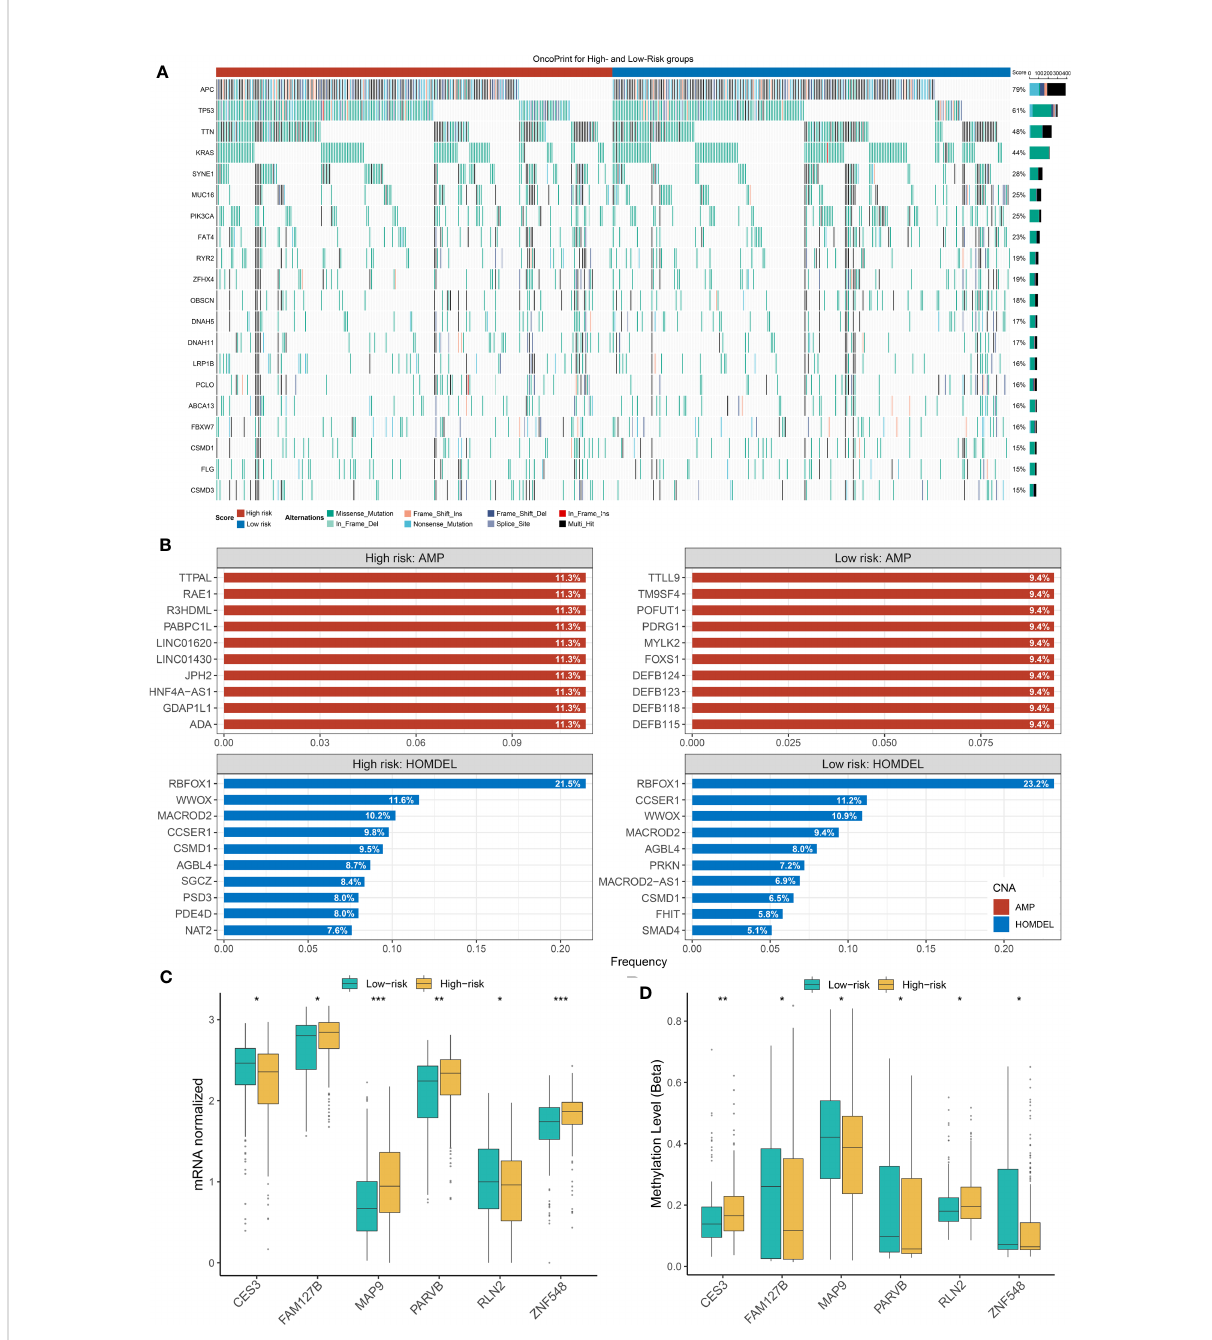
FIGURE 6 The Landscapes of frequently mutated genes (FMGs) and methylation level in two groups of NLncS. (A) The oncoplot depicts the discrepancies in FMGs of CRC among the three cohorts. (B) The top 10 genes were ampli fi ed and homozygously deleted in the high- and low-risk groups. (C, D) The expression and methylation level of the methylation drivers in CRC. (*P< 0.05; **P< 0.01; *** P<